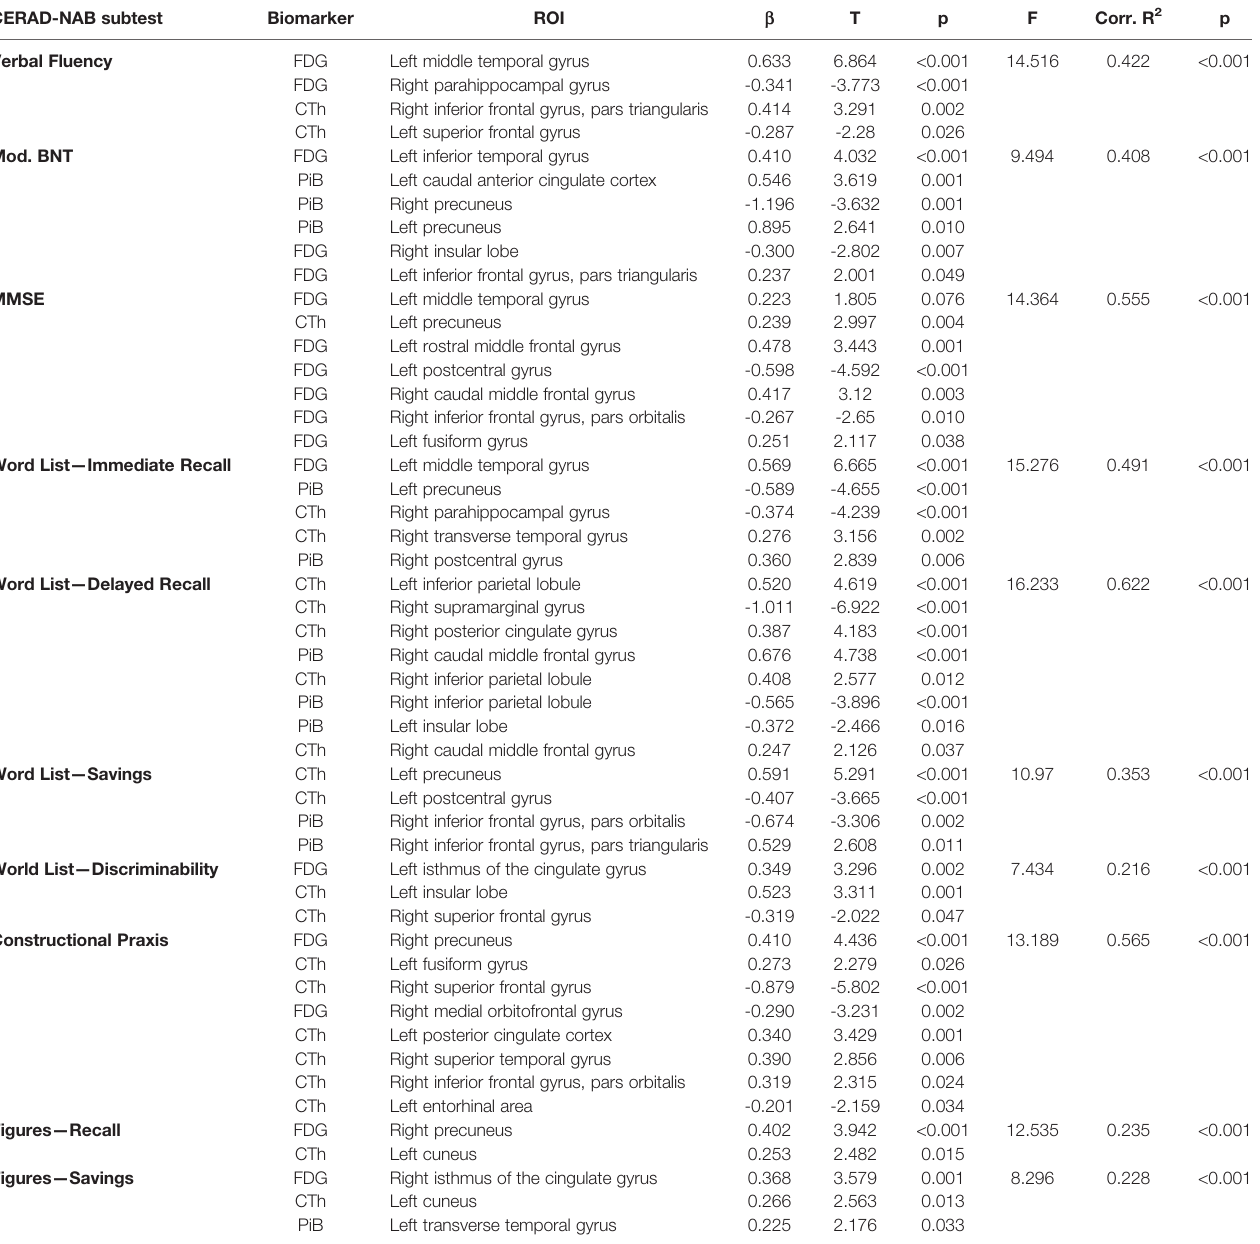
TABLE 5 | Relationship between cognitive performance and multimodal ROI-based biomarker information. CERAD-NAB subtest